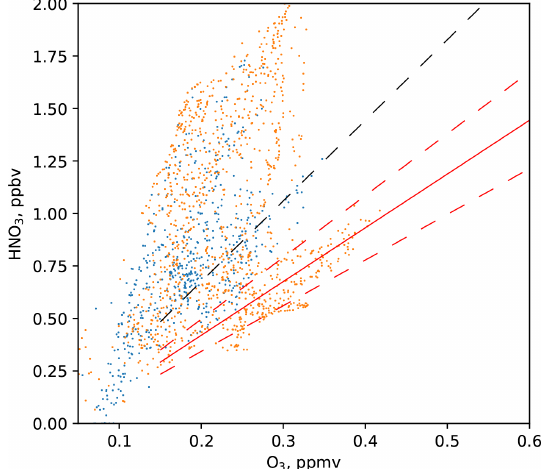
Figure 14. Ozone–nitric acid tracer–tracer correlation for air parcels observed in both flights. Tracer concentrations measured on 7 October (3-D tomographic retrieval) are shown in orange; those measured on 9 October are in blue. The solid red line represents lin- ear relationship of ozone and nitric acid typical for the stratosphere. Dashed red lines indicate the ± 15% HNO 3 compared to that rela- tionship; the dashed black line indicates + 50% HNO 3